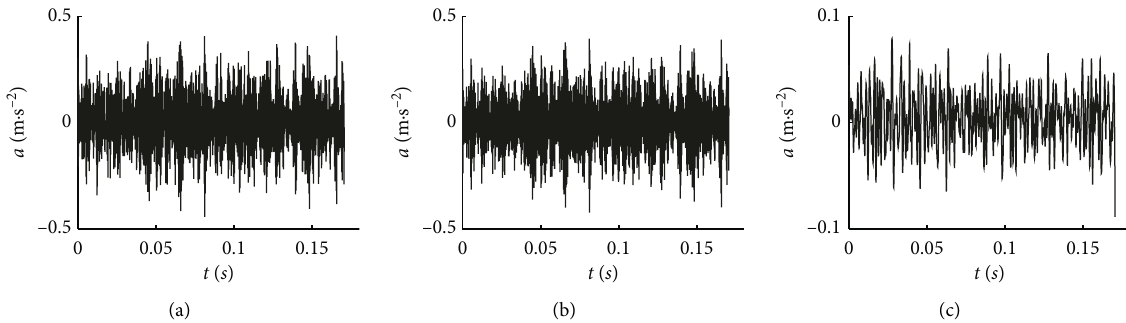
Figure 7: The SPA decomposition results of the BF07: (a) BF07; (b) trend terms; (c) detrend